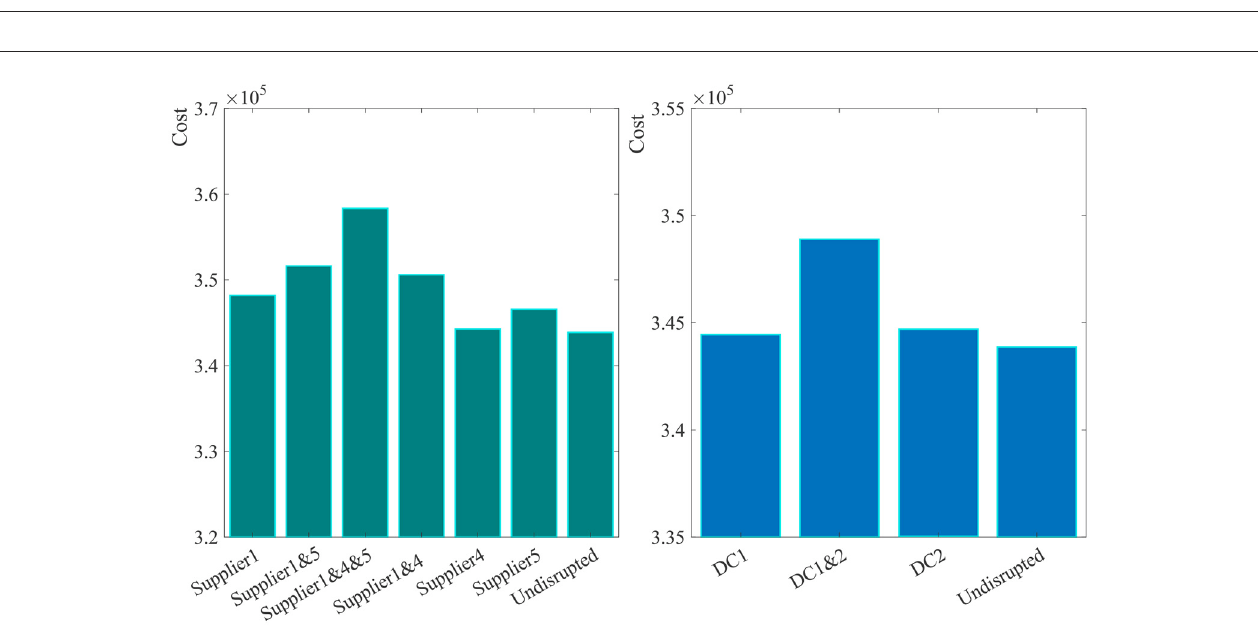
FIGURE5 The expected total cost under different disruption